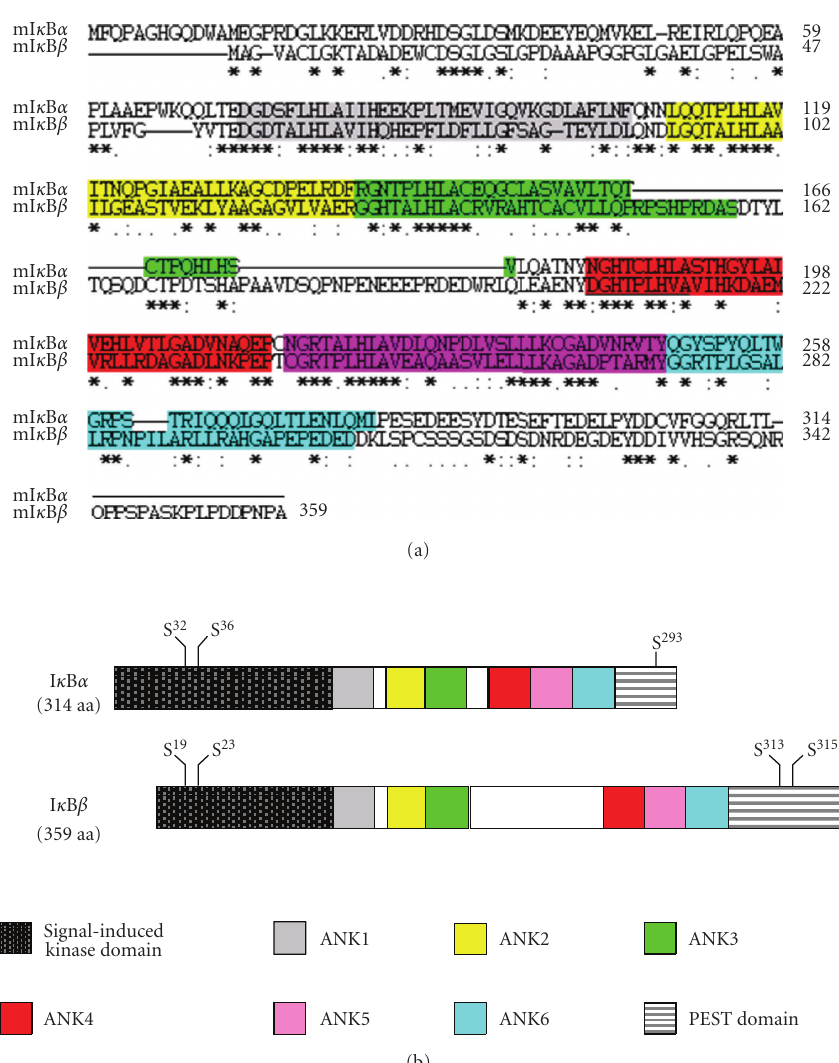
Figure 4: Amino Acid Sequence Comparison between I κ B α and I κ B β . (a) Alignment of amino acid sequences of mouse I κ B α and I κ B β is shown. The six highly conserved ANK repeats in both proteins are highlighted in grey, yellow, green, red, pink, and blue, respectively. (b) A cartoon illustrating a comparison of the slightly di ff erent structural domain organizations of mouse I κ B α and I κ B β proteins. The signal-induced kinase domain, six ANK repeats, and PEST domain of each protein are